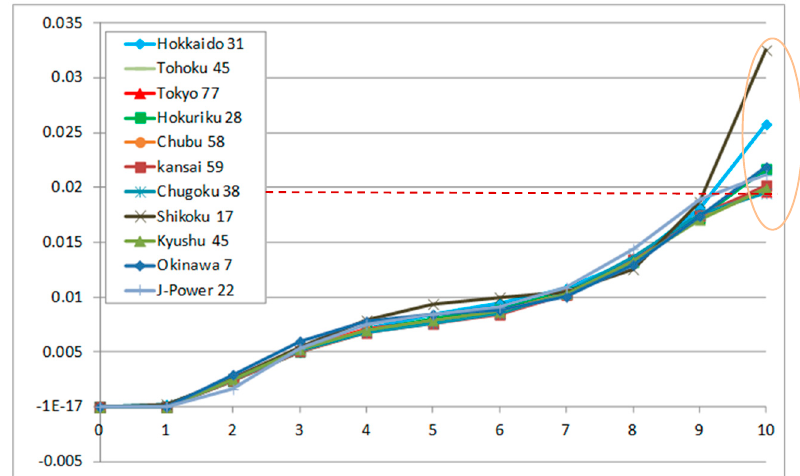
Figure 12. Term structure of default probabilities (TSDPs) of 10 companies in electric power industry. Monthly Changes of TSDPs of TEPCO from September 2006 through August